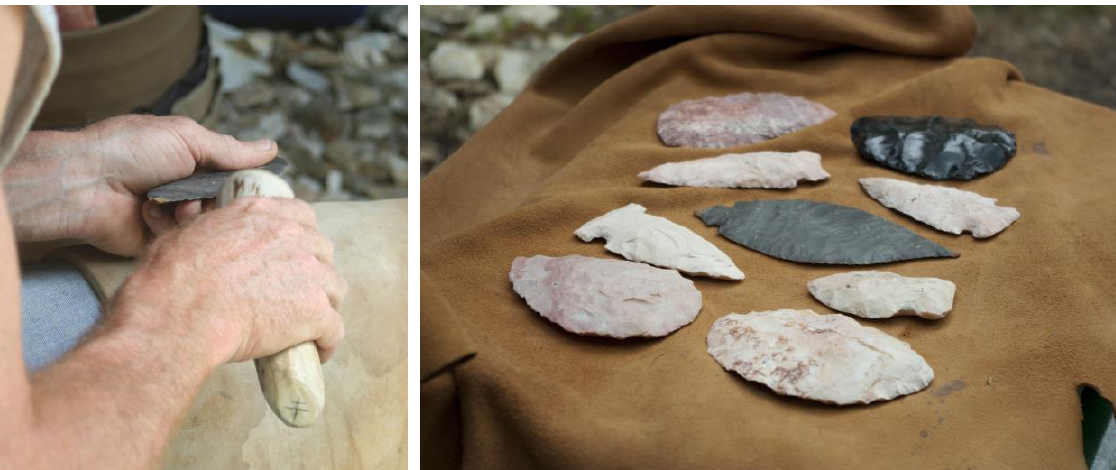
Figure 2 (left). Tim Dillard thinning a Turkey Tail biface. These artifacts were found in sacred contexts and exceptionally difficult to produce. Tim’s skill level in billet percussion is unmatched. (Photo by Jeanne Binning.) Figure 3 (right). Biface performs, atlatl dart points, and knifes made by students and Tim Dillard with both local and non-local materials. (Photo by Center for American